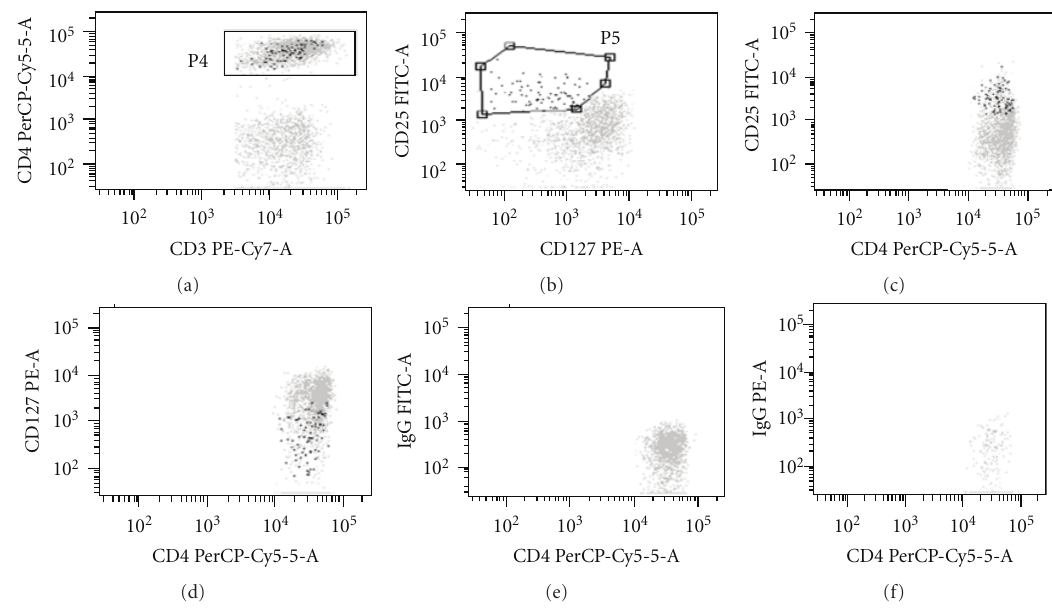
Figure 1: Treg gating strategy. Representative bivariate dot plots illustrating gating strategy used to enumerate lymphocytes with the CD3+CD4+CD25highCD127low phenotype (Treg) in the same blood sample. The settings showed here were used for the analysis of all peripheral blood samples. Events corresponding to Treg are shown as black dots, events corresponding to other lymphocytes are shown as gray dots in all bivariate dot plots. (a) Gate shows CD3+CD4+ events corresponding to T-helper lymphocytes; (b) CD25highCD127low events corresponding to Treg are displayed in the gate; (c) bivariate dot plot illustrating the CD4+CD25high phenotype pattern of Treg; (d) bivariate dot plot illustrating the CD4+CD127low phenotype pattern of Treg: (e) and (f) bivariate dot plots showing appropriate isotype controls. CD: cluster of di ff erentiation.